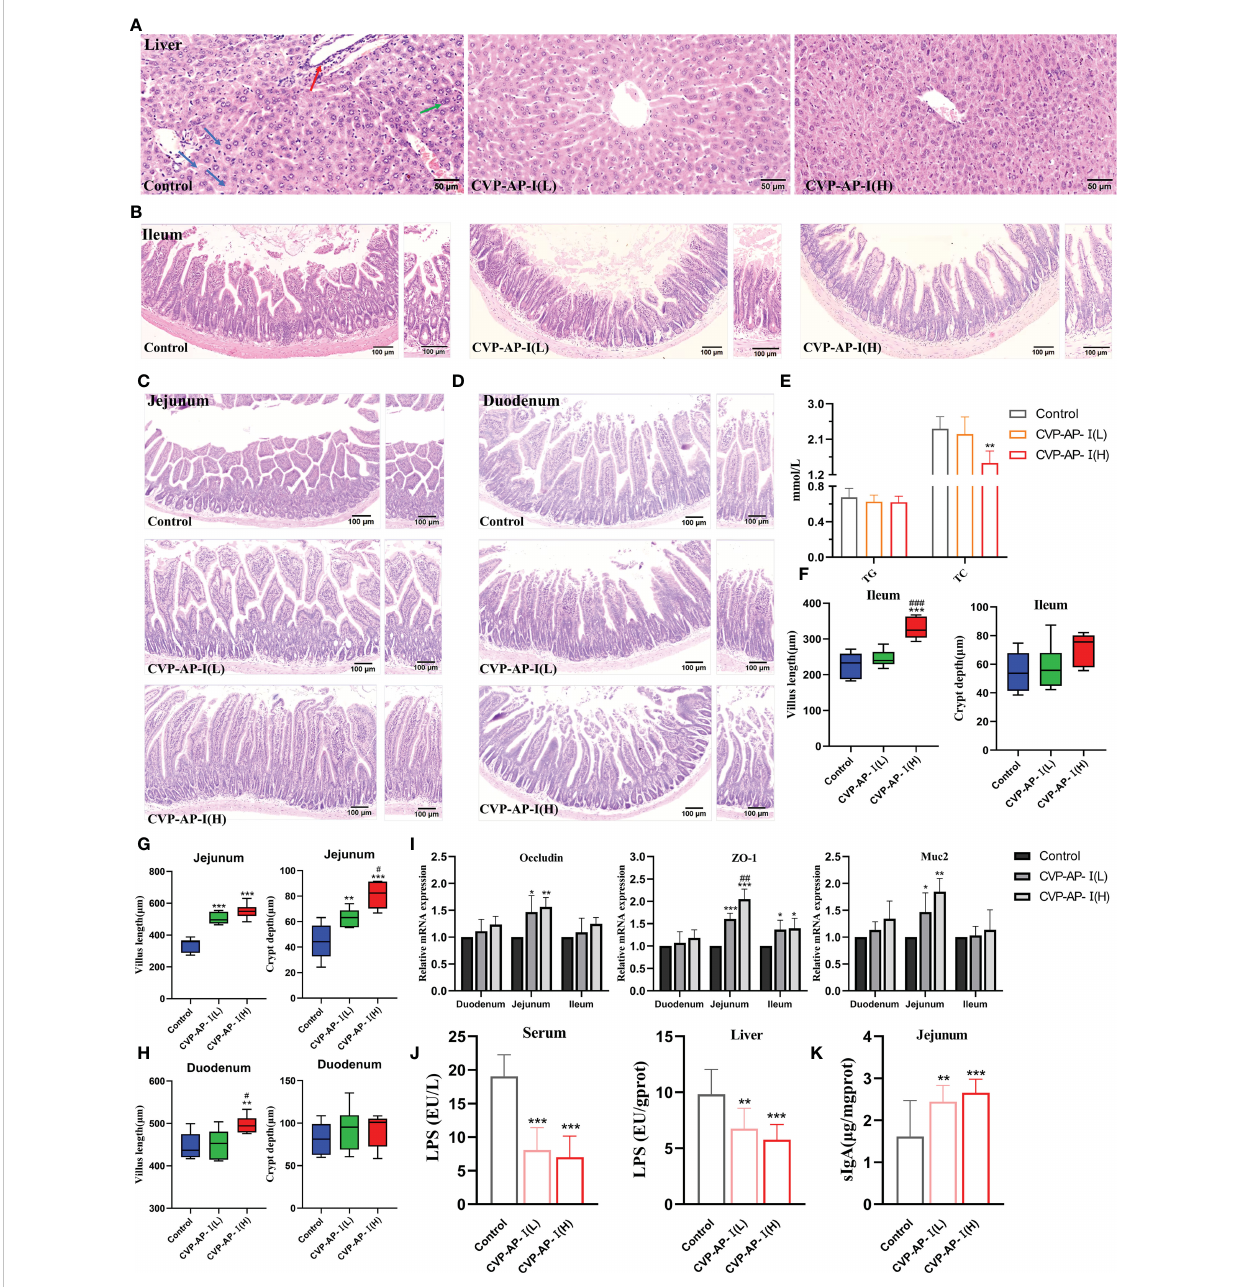
FIGURE 5 Effects of CVP-AP-I on liver and intestinal histology and intestinal immune barrier in naturally aging mice. (A) Representative images of H.E staining show that CVP-AP-I improves age-induced liver lesions. ( “ ! ” In fl ammatory cell necrosis of the liver; “ ! ” Multinucleated hepatocytes; “ ! ” Mild steatosis of hepatocytes); (B-D) Representative images of H.E staining show that CVP-AP-I reverses aging-induced villus and crypt defects in the ileum, jejunum and duodenum; (E) Quanti fi cation shows the levels of TG and TC in the serum of different groups of mice(n=4); (F-H) Quantitative show of CVP reversal of aging-induced intestinal villus and crypt defects in the ileum, jejunum and duodenum. Error bars indicate Mix to Max (n = 6); (I) qRT-PCR results show the expressions of Occludin, ZO-1 and Muc2 in duodenum, jejunum and ileum of mice from different groups (n=4); (J) Quanti fi cation shows LPS levels in the serum and liver of different groups of mice (n=4); (K) Quanti fi cation shows sIgA levels in the jejunum of different groups of mice (n=6). All data are expressed as mean ± SD. * p <0.05, ** p <0.01, and *** p <0.001 as compared with Control Group. # p <0.05, ## p <0.01, and ### p <0.001 as compared with CVP-AP-I(L)